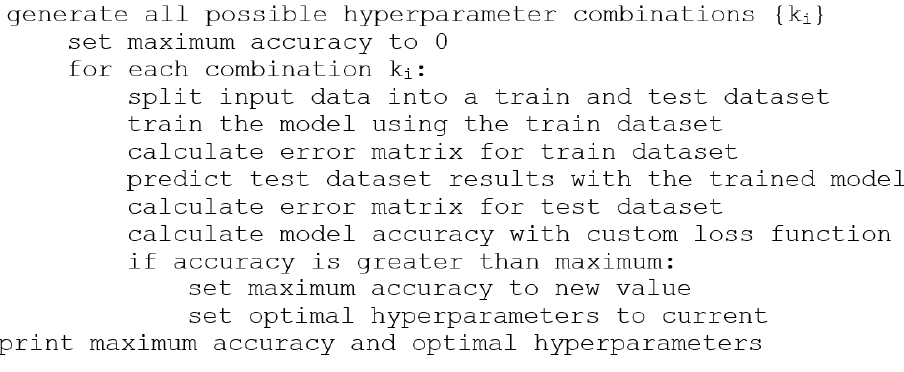
Figure 5. Pseudocode of the full search process for finding optimal hyperparameters.